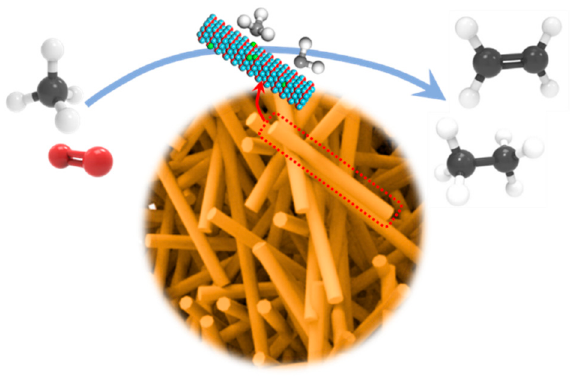
Figure 9. The reaction mechanism OCM over nanorod X-La 2 O 3 catalysts.